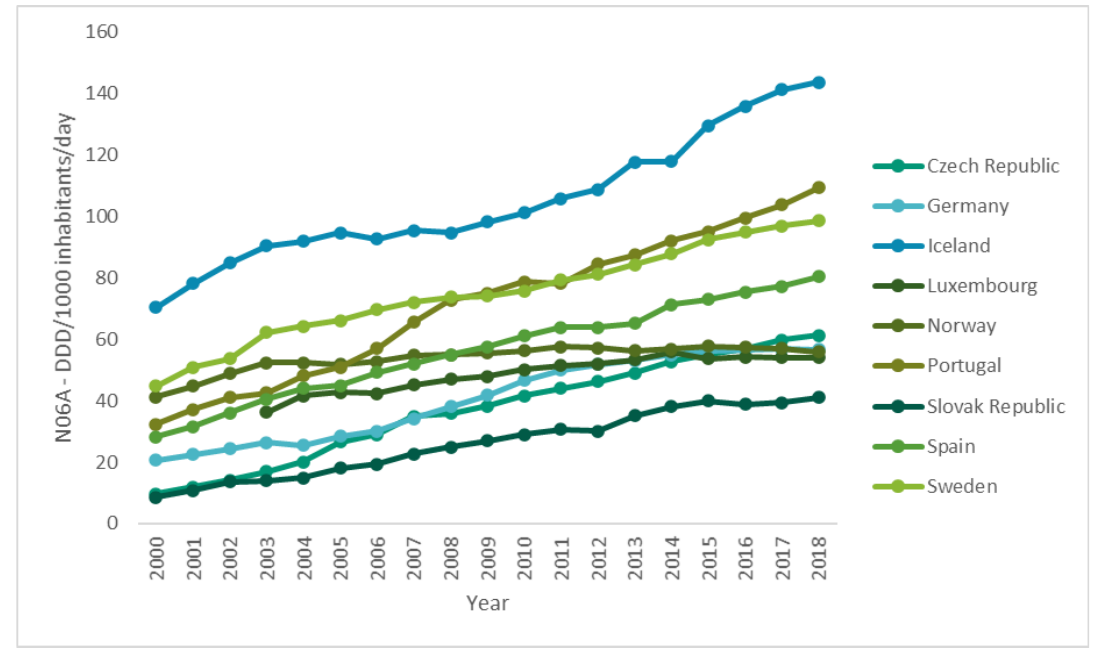
Figure 3. Use of antidepressants (N06A) in some OECD countries from 2000 to 2017 (DDD/1000 inhabitants/day) (data from [24]).